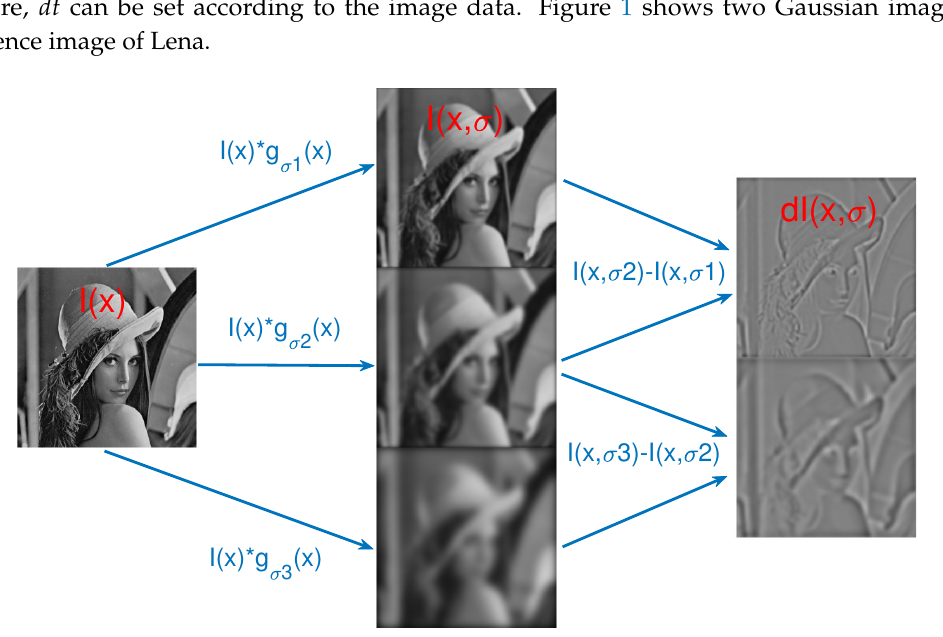
Figure 1. Gaussian scale space of Lena